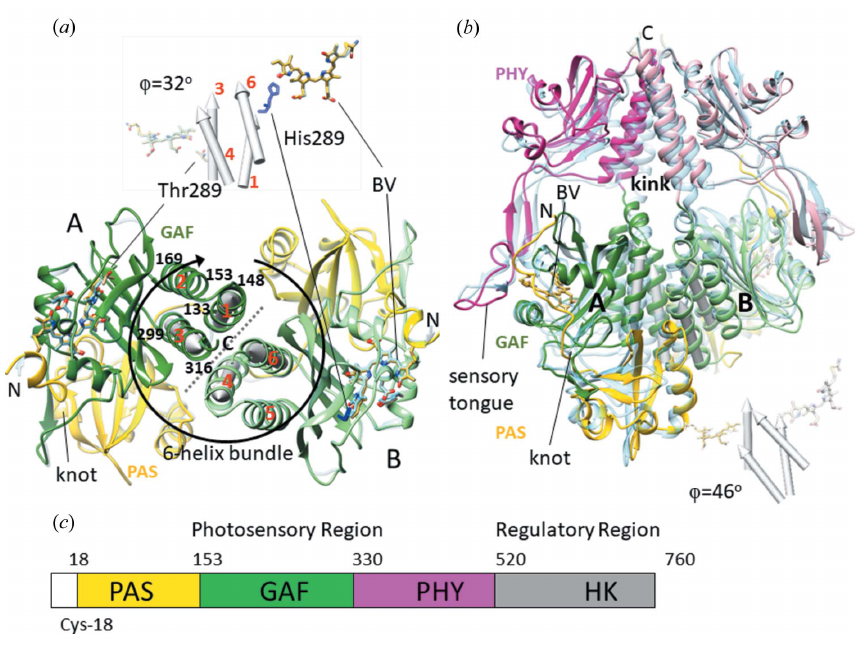
Figure 5 Comparisons of the SaBphP1 CBD ( a ) and PCM ( b ) in the wild-type and T289H mutant forms. The PAS, GAF and PHY domains are colored yellow, green and magenta, respectively. ( a ) Overlay of the wild-type CBD (yellow, green) on the T289H mutant CBD (light blue). The CBD is a dimer (marked A and B) which is generated from the monomer in the asymmetric unit by a crystallographic symmetry operation. Thr289 is marked in subunit A, and His289 in subunit B. The circular arrow denotes the six- helix bundle (helices numbered one to six in red, residue numbers are marked) that forms the dimer interface (gray dotted line). The four interacting helices are highlighted by cylinders, which are also displayed in isolation above the structure. The dimer is rotated so that helices four and six of subunit B lay on top of helices one and three of subunit A. The offset angle ’ between the subunits is measured as described in Appendix B 3. ( b ) Overlay of the wild-type PCM (yellow, green, magenta) on the T289H mutant PCM (light blue). The four helices at the dimer interface are displayed for both constructs below the structure. The angle between the interfaces ’ increases by 14 (cid:6) compared with the CBD. The knot, the kink at the helical transition from GAF to PHY and the sensory tongue are marked. ( c ) Domain organization of BphPs. Sequence numbers are provided for